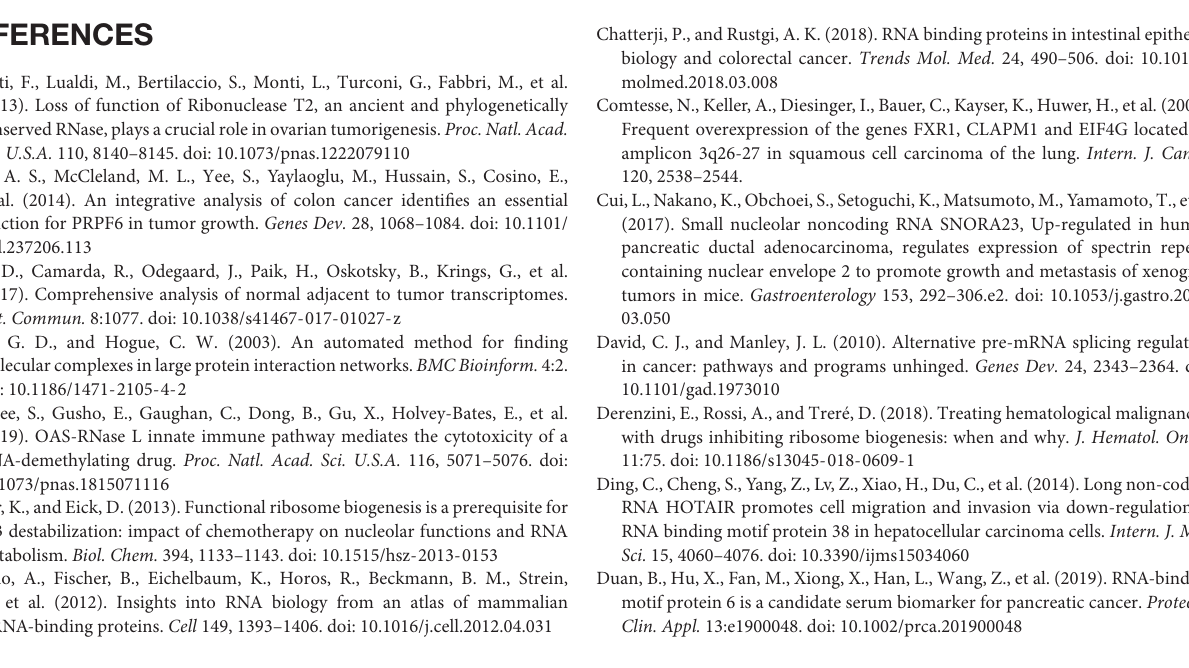
Supplementary Figure 1 | Gene set enrichment analysis (GSEA) analysis for differentially expressed RBPs between normal and tumor groups in PAAD. P -value < 0.5 and | NES| > 1were considered significantly. Supplementary Table 1 | Gene set enrichment analysis (GSEA) for eight modeling RBPs. (| NES| > 1 and NOM p -value < 0.05 were considered